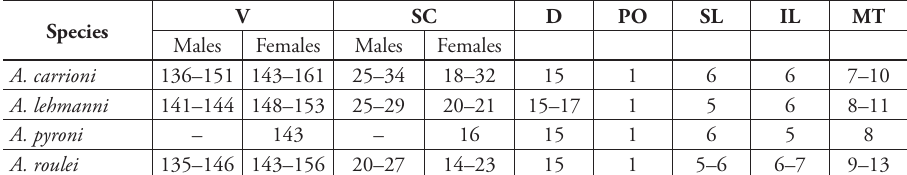
Table 3. Morphometric data for members of the Atractus roulei species group. Codes are: V=ventrals; SC=subcaudals; D=dorsal scale rows at midbody; PO=postoculars; SL=supralabials; IL=infralabials; MT=maxillary teeth. Data is derived from Appendix III and from the